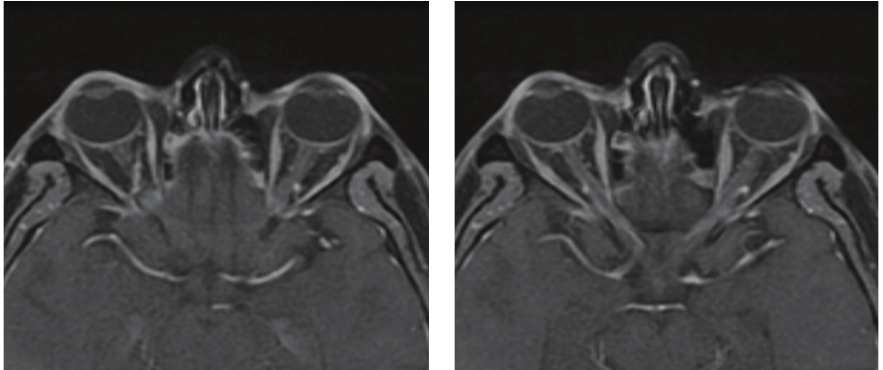
Figure 2: Optic MRI without